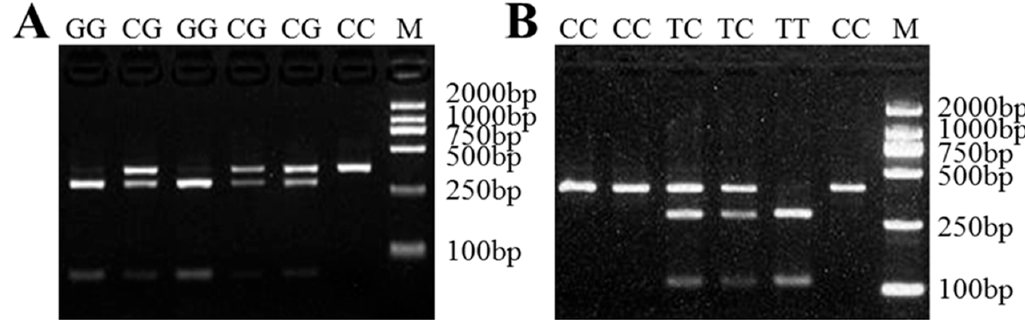
Figure 4. The PCR-RFLP results for the di ff erent genotypes of sheep LAP3 . The genotypes are marked